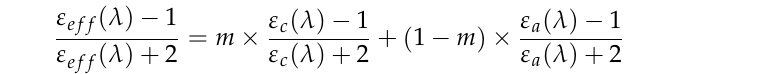
Figure 4. ( a ) Solar spectra under AM1.5, amorphous and crystalline states; ( b ) coordinates on the color change more dynamic and flexible. chromaticity diagram of the aSb 2 Se 3 and cSb 2 Se 3 states with their corresponding displayed colors. The phase transition from aSb 2 Se 3 to cSb 2 Se 3 is a dynamic change process, which